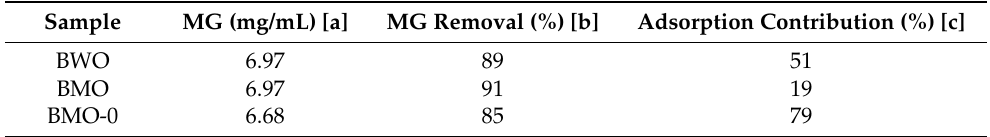
Table 2. Main experimental observations of photocatalytic